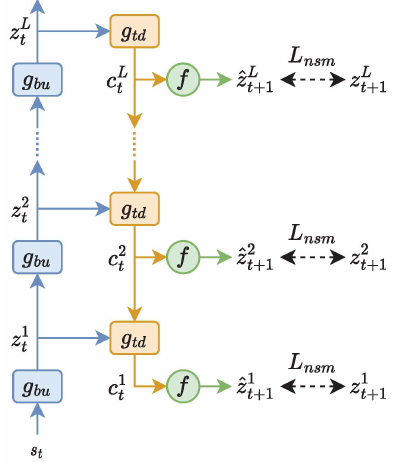
Figure 1. General scheme of the proposed method. A BERT-type model ( g bu ) is augmented with a top-down network ( g td ) which generates a contextual vector c at each layer to predict the next sentence representation ˆ z t + 1 through a predictive layer ( f ). The predicted representation ˆ z t + 1 is then contrasted with the actual one z t + 1 to compute L nsm to optimize the complete